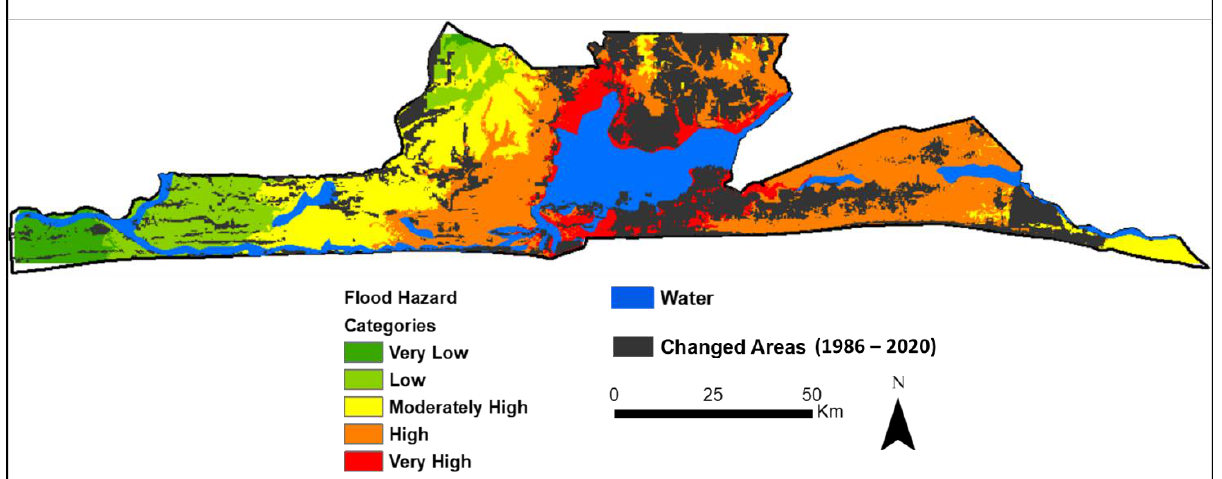
Figure 9. An overlay of developed areas on the flood hazard map. Table 8. Analysis of changes in flood hazard areas.